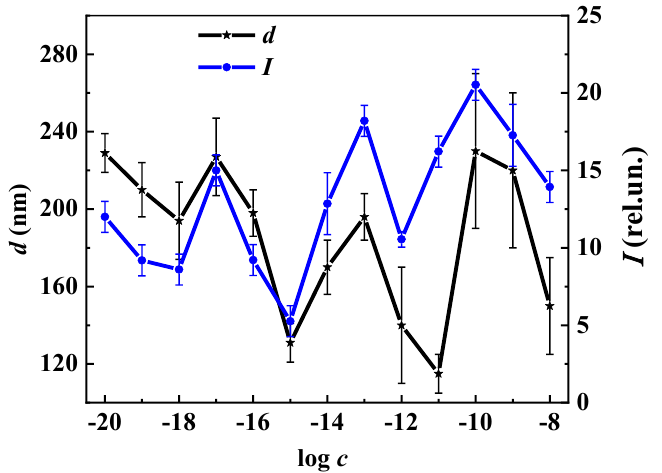
Figure 8. Dependence of the particles’ size (d), the fluorescence intensity (I) ( λ ex 225 nm, λ em 340 nm) on the concentration (c, mol/L) of the L -Trp systems, 25 ◦